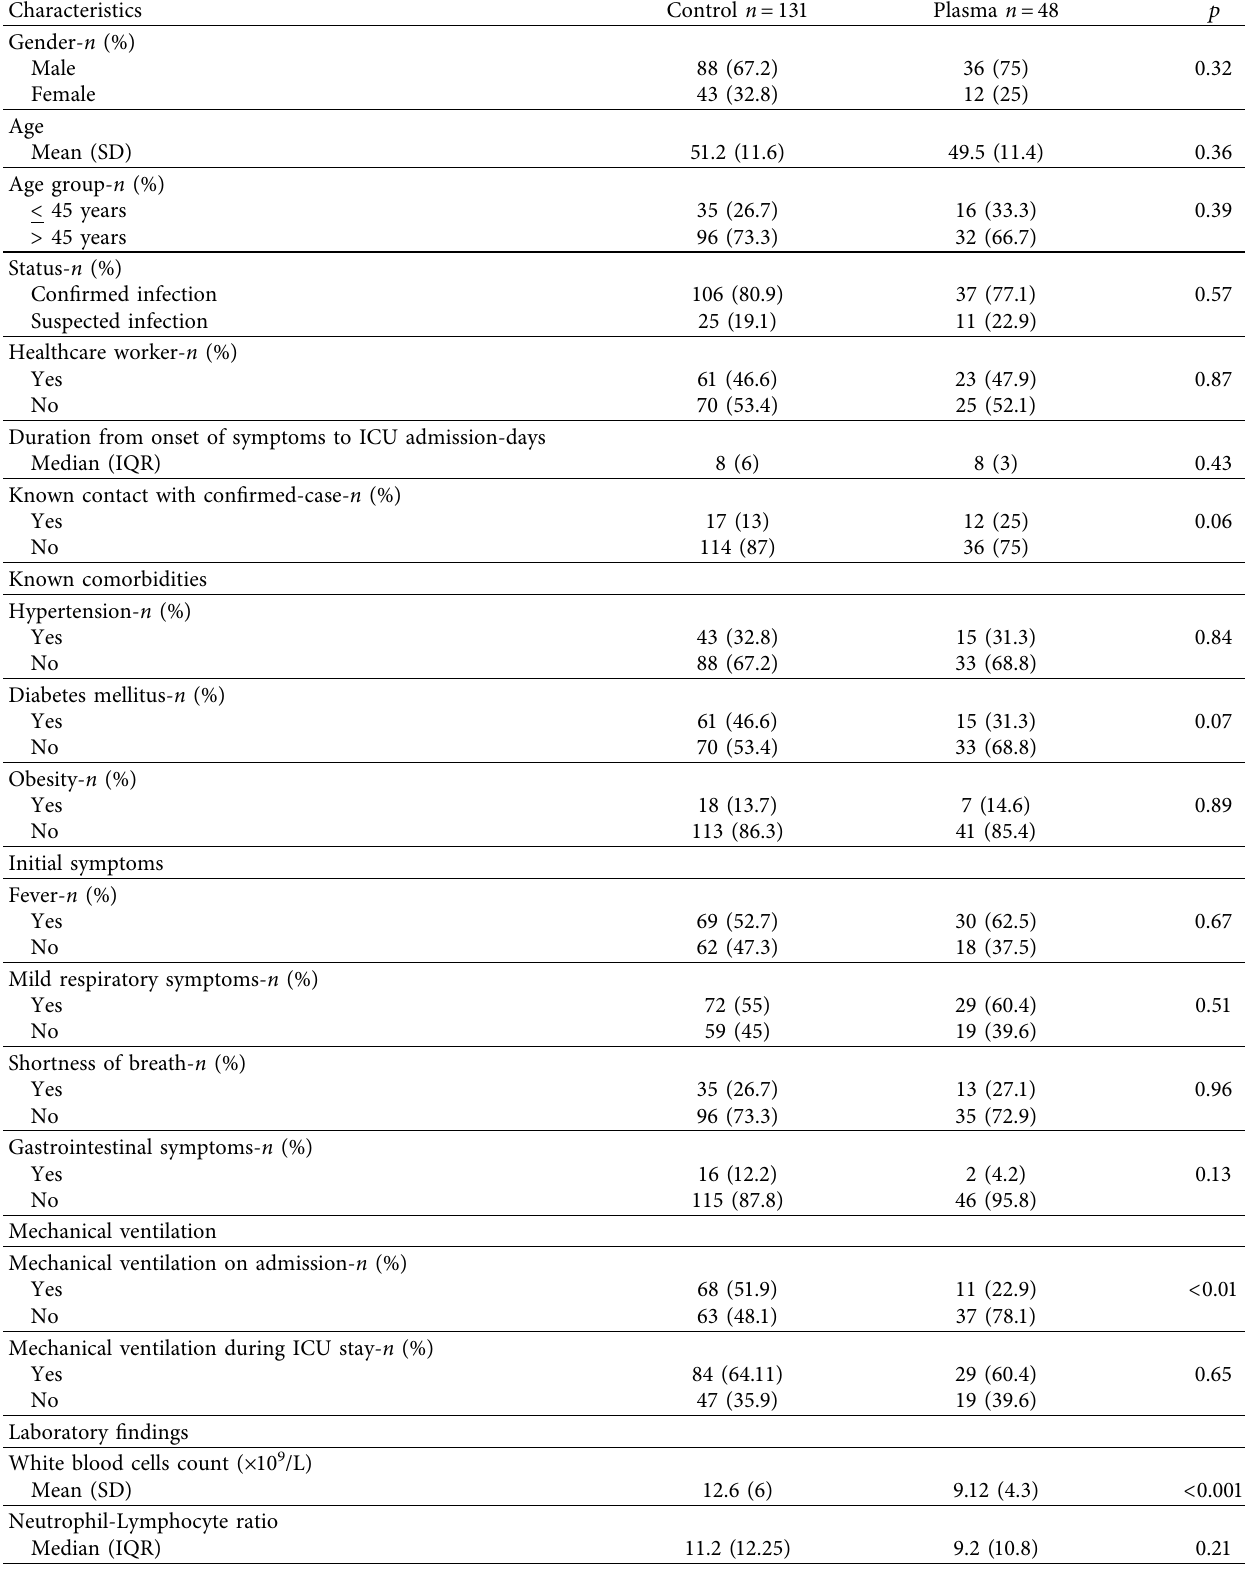
Table 1: Baseline characteristics of both